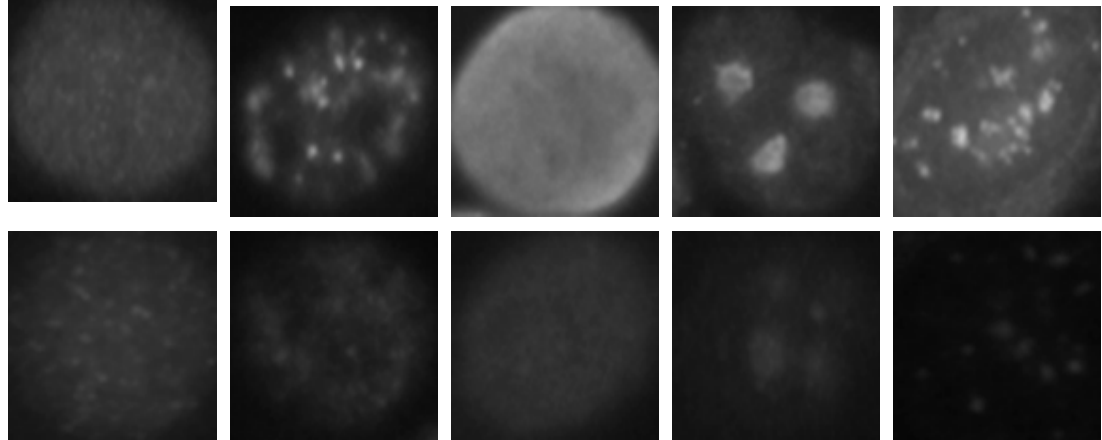
Figure 9. HEp-2 cell images from one of the SNPHEp-2 dataset. In the first row, we have the positive intensity images while the second row depicts the intermediate intensity images. For both rows we have, from left to right, the Homogeneous, Coarse Speckled, Fine Speckled, Nucleolar and Centromere cells.